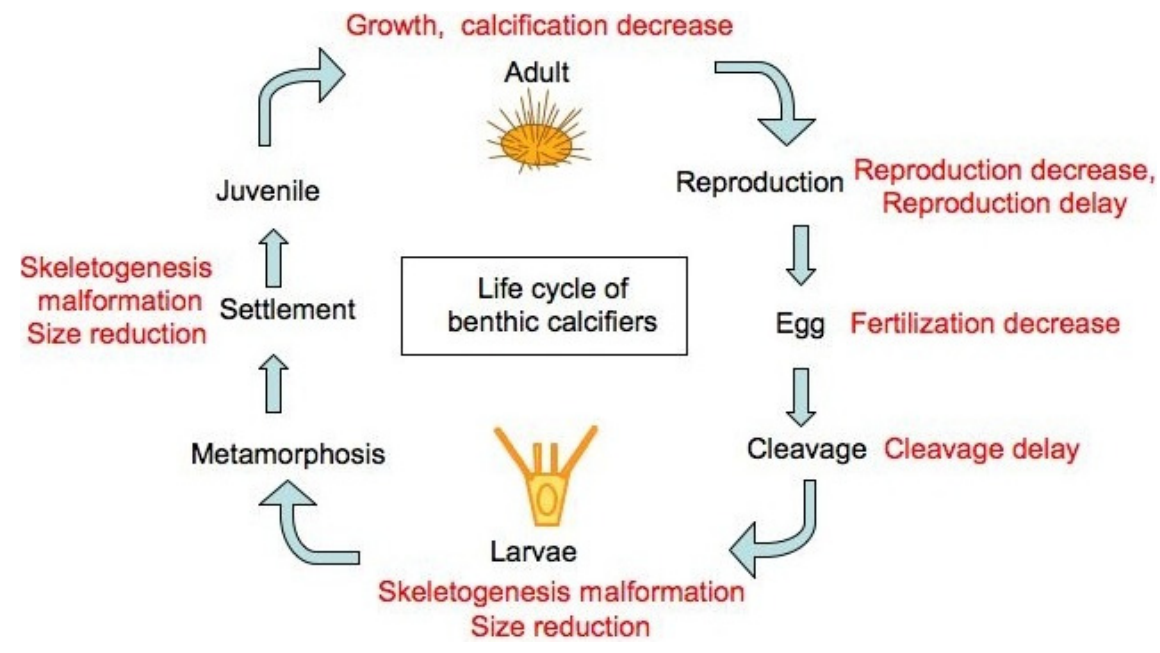
Figure 2. Summary of the major impacts of ocean acidification on the fertilisation, larval development and settlement of broadcast spawning benthic invertebrates